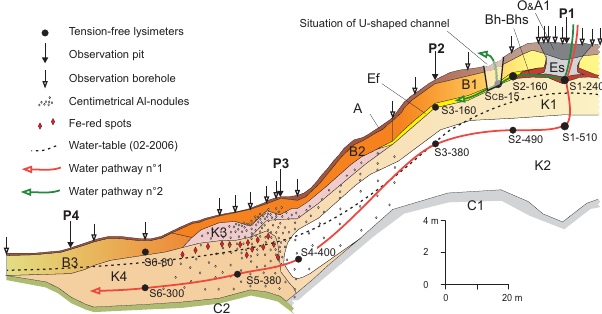
Fig. 2. View of the soil system along the catena. Capital letters of horizon names refer to FAO (1993). O: organic, peat-like horizon; A1: organic-rich, dark brown horizon; A: horizons brown-colored by organic matter; Es: podzolic eluviated horizons; B1: oxic B hori- zons varying from sandy upslope to sandy-clayey downslope; B2: oxic sandy-clay B horizons; B3: pseudogley B horizons; K: kaolin horizons; Bh-Bhs: horizons with organic matter and Al-Fe accu- mulation; Ef: non-podzolic leached horizon; C1 and C2: saprolitic horizons. P1 to P4: situation of mineralogical data given in Table